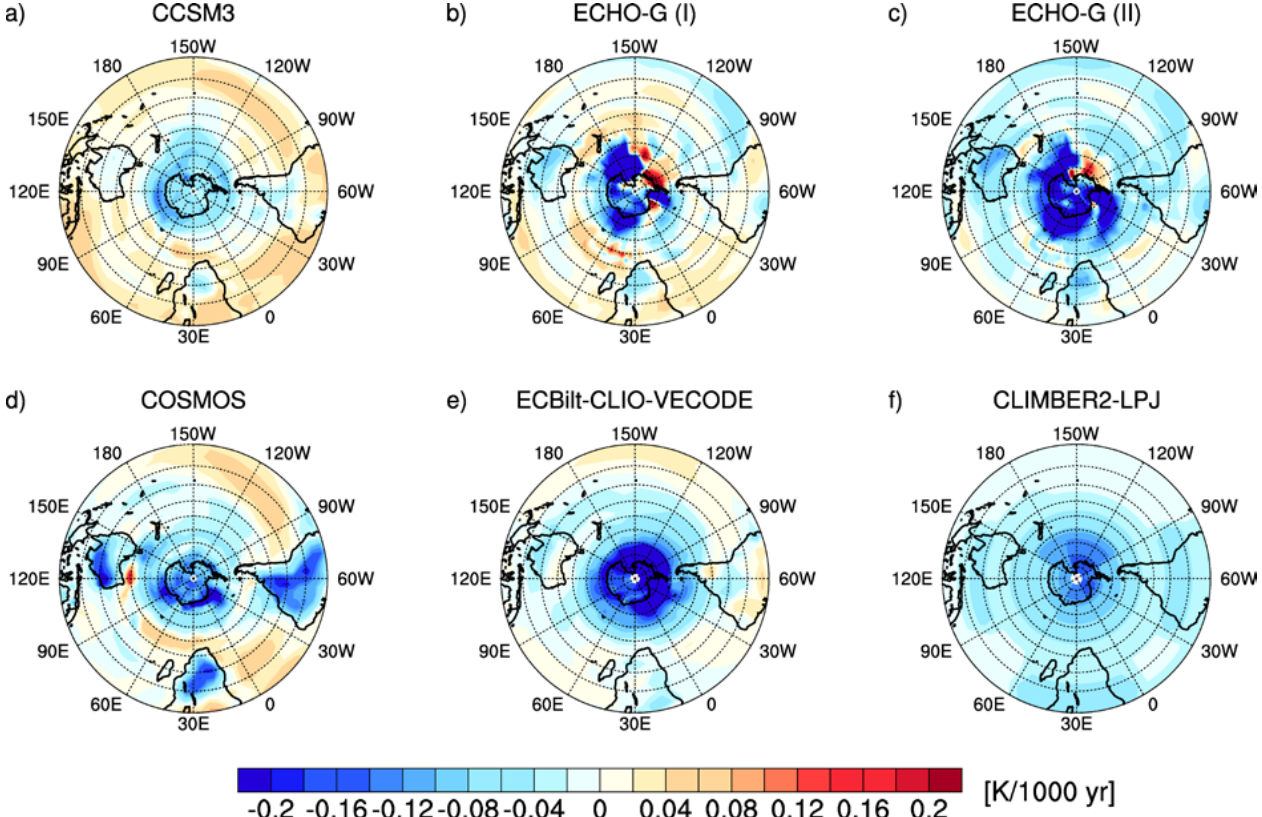
Figure 6. Trend in the annual mean surface temperature in a) CCSM3, b) ECHO-G (I), c) 797 Fig. 6. Trend in the annual-mean surface temperature in (a) CCSM3, (b) ECHO-G (I), (c) ECHO-G (II), (d) COSMOS, (e) ECBilt-CLIO- VECODE, and (f) CLIMBER2-LPJ for the period 7kyr BP to 250yr BP. ECHO-G (II), d) COSMOS, e) ECBilt-CLIO-VECODE, and f) CLIMBER2-LPJ for the 798 period 7 kyr BP to 250 yr BP. 799 (see Figs. 6–9 of the Supplement for the Southern Hemi- sphere maps of seasonal trends in surface temperature).